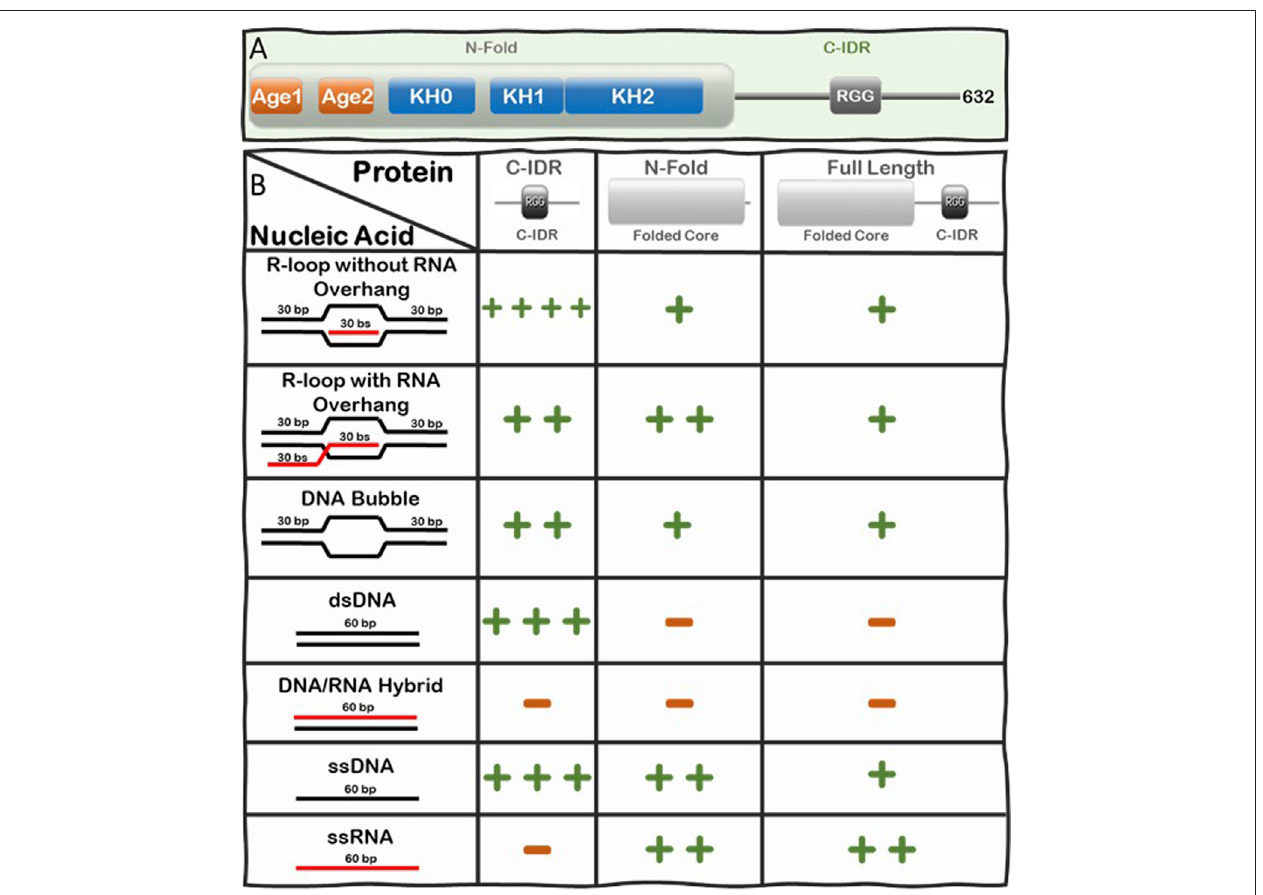
FIGURE 3 | Summary of the Interactions of FMRP full-length, N-Fold, and C-IDR with R-loops and substructures. (A) Modular domain architecture of FMRP showing the N-terminal folded core (N-Fold), consisting of two Agenet domains and three KH domains, and the C-terminal intrinsically disordered region (C-IDR). (B) Table showing the relative strength of binding between FMRP constructs (top row) and various nucleic acid substrate controls (left column), such as R-loops with (out) RNA overhang, DNA bubble, dsDNA, DNA:RNA hybrid, ssDNA, and ssRNA. Binding af fi nity for each FMRP construct and nucleic acid substrates was calculated as dissociation constants (K D s) averaged from at least two Electrophoretic Mobility Shift Assay (EMSA) experiments(Chakraborty et al., 2021). K D values are scaled accordingtoalogscale:(++++)means1 – 10 nM;(+++)means11 – 100 nM;(++)means0.1 – 1 μ M;(+)means1 – 10 μ M;and( − )meansnoobservedinteractionunderthe bindingconditions usedfor theEMSAassay(i.e.,1 nM of γ -P(Muramatsu etal.,2000)R-loop,RNA-DNAhybrid,dsDNA, bubbleDNA, ssDNA,or RNAsubstratemixed with protein at various concentrations in a buffer composed of 25 mM Tris-HCl (pH 7.5), 100 mM KCl, 5 μ g/ml BSA, and 5 mM EDTA. Details of the original SDS PAGE gels of the protein constructs and the phosphorimages of the EMSA gels, data quanti fi cation, binding curves where the K D s are extracted are all shown in Figure 2 and Supplementary Figure S2 in ref (Chakraborty et al., 2021).